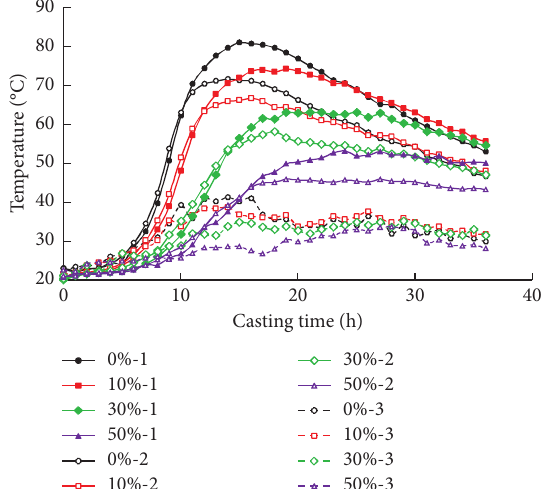
Figure 10: Relationship between the temperature difference and the casting time (containing fly